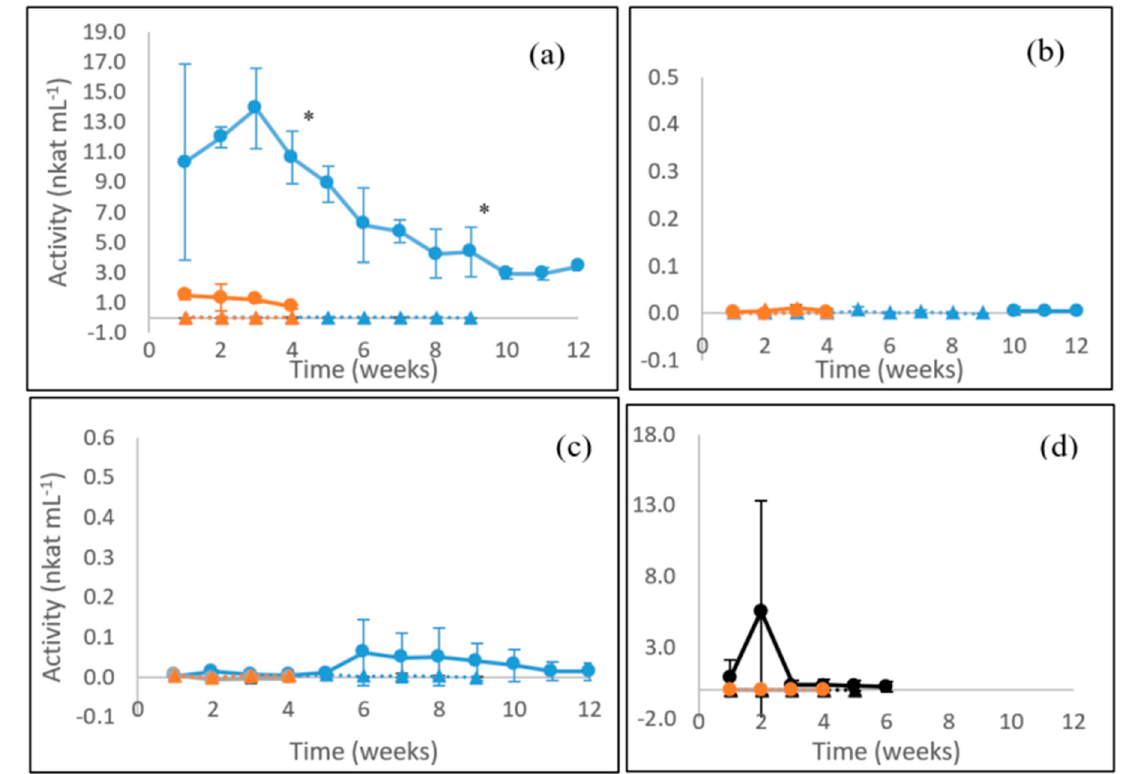
Figure 1. Laccase activities produced by ( a ) the WR fungus P. radiata ; ( b ) the BR fungus F. pinicola ; ( c ) the GR fungus S. commune ; and ( d ) the LDF species C. cinerea . Fungal cultivations on birch wood (blue line with spheres), on barley straw (black line with spheres) and on liquid ME medium (orange line with spheres). Values from control incubations of birch wood (blue triangles), barley straw (black triangles) and liquid ME medium (orange triangles) without fungi are included. Mean value ( n = 3) is presented at each week time point. Bars indicate the standard error. * statistically significant changes between time points. Notice different scales in the y axis. For information on the fungi, see Table 1.